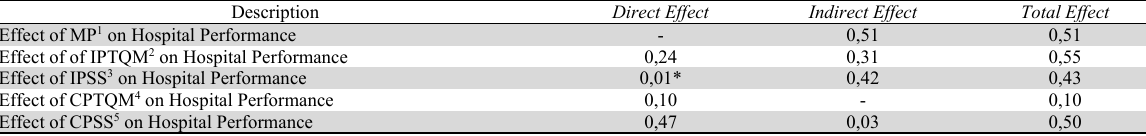
Fig. 2. CFA Model Path Chart 2nd order (Standardize Load- ing) Effect of Total Variable QMA Model on Hospital Performance in Jambi Province